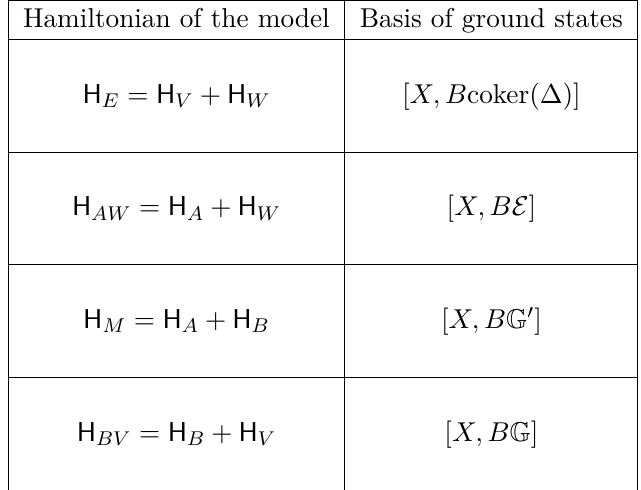
Table 1 . The ground states for four models described by integrable hamiltonians containing two out of four terms of H . Here [ X, Y ] is the set of homotopy classes of maps X → Y . For the first two entries, the relevant spaces Y are classifying spaces of groups. In the last two entries classifying spaces of crossed modules are meant. G 0 is the crossed module consisting of the trivial homomorphism ker(∆) → E and action of E on ker(∆) inherited from the crossed module G .